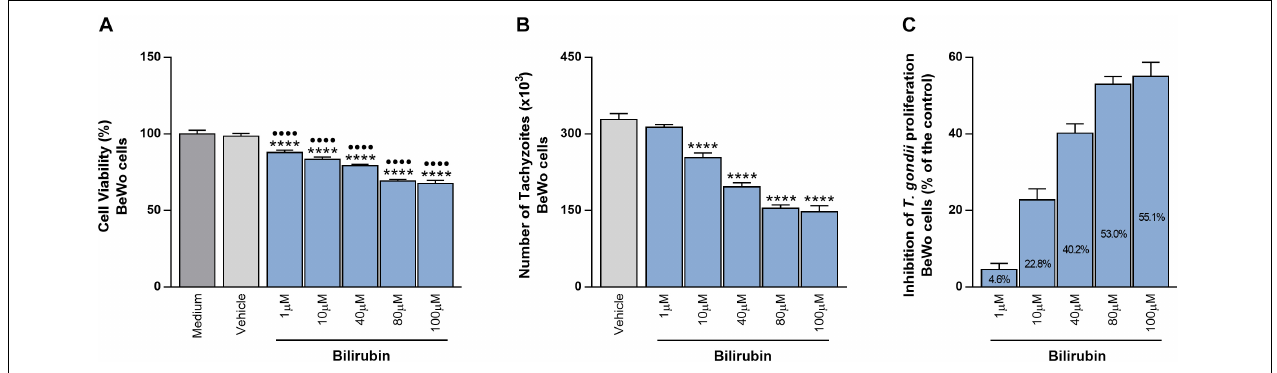
FIGURE 3 | Effects of exogenous bilirubin treatments on T. gondii proliferation in BeWo cells. (A) BeWo (3 × 10 4 cells/200 µ l/well) cells were cultured in 96-well plate during 24 h, treated with exogenous bilirubin (1, 10, 40, 80, or 100 µ M) or incubated with vehicle (DMSO at 0.2%) or only medium (control) for additional 24 h and submitted to MTT assay. The data were shown as the percentage of viable cells in relation to untreated cells (medium as 100% of viability). Statistical differences in relation to medium ( • ) or in relation to vehicle (*). (B) BeWo (3 × 10 4 cells/200 µ l/well) cells were cultured for 24 h, infected with T. gondii (1:1) for 3 h, treated with exogenous bilirubin (1, 10, 40, 80, or 100 µ M), or incubated with vehicle (DMSO at 0.2%) during 24 h, and the T. gondii intracellular proliferation was analyzed by the β -galactosidase assay. The data were shown as number of tachyzoites ( × 10 3 ), used to calculate the inhibition of T. gondii proliferation (%) (C) . Statistical differences in relation to vehicle (*). For all assays, the results were expressed as mean ± SEM from two independent experiments performed in six or eight replicates. Significant differences were statistically assessed by one-way ANOVA with Bonferroni’s posttest (A,B) ; ••••∗∗∗∗ P <